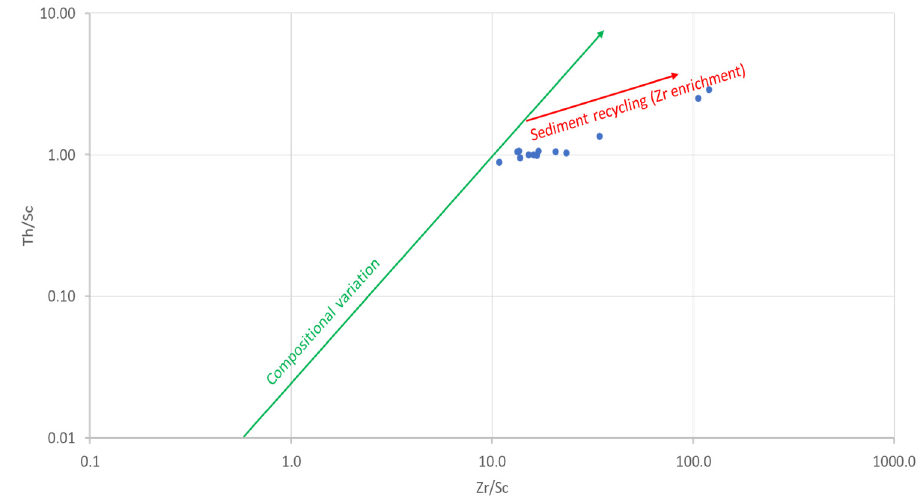
Figure 11. Th/Sc versus Zr/Sc plot showing sedimentary recycling in studied geophagic clays. Fields from McLennan et al. [67]. Reprinted with permission from ref. 1138320-1. Copyright 1993 Geological Society of America.